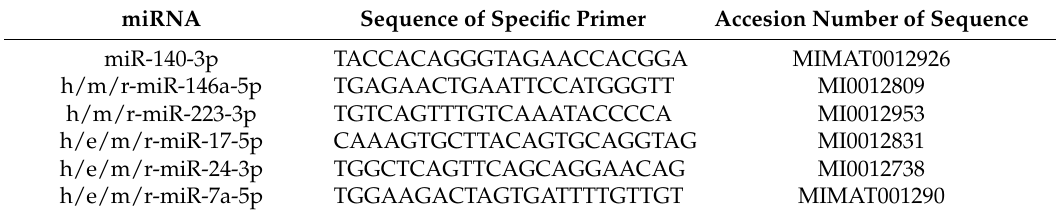
Table 2. The list of miRNA specific primers used in the